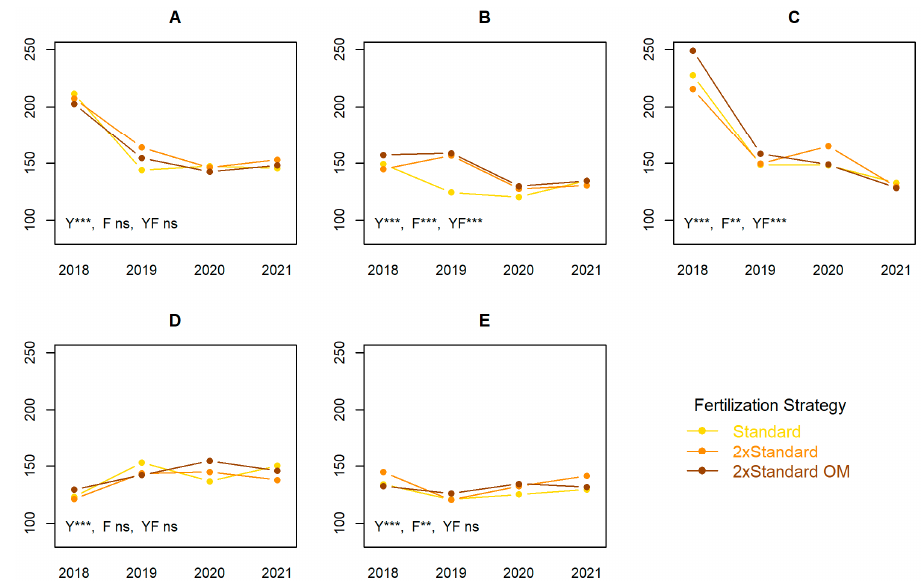
Figure 5. Average weight per fruit (g) of orchards ( A – E ). Each plot refers to an orchard. Each dot represents the average of 15 replicates (apple trees) observed for a given year and fertilization strategy. Lines join points with the same fertilization strategy. An ANOVA model with 2 factors (Year and Fertilization strategy) with interaction was fitted to the data of each plot. The significance of each F-test is also presented. Y: year, F: fertilization strategy, YF: interaction. “***” for p -value < 0.01, “**” for 0.01 < p -value < 0.05 and “ns” for p -value > 0.1. Table 8. TSS ( ◦ Brix) and Firmness (kg cm − 2 ) in fruits measured at harvest time for each year and orchard. Means and standard deviations where obtained with 42 observations. Letters show the means that are significantly different in a two-way ANOVA with interaction model with Year and Orchard as